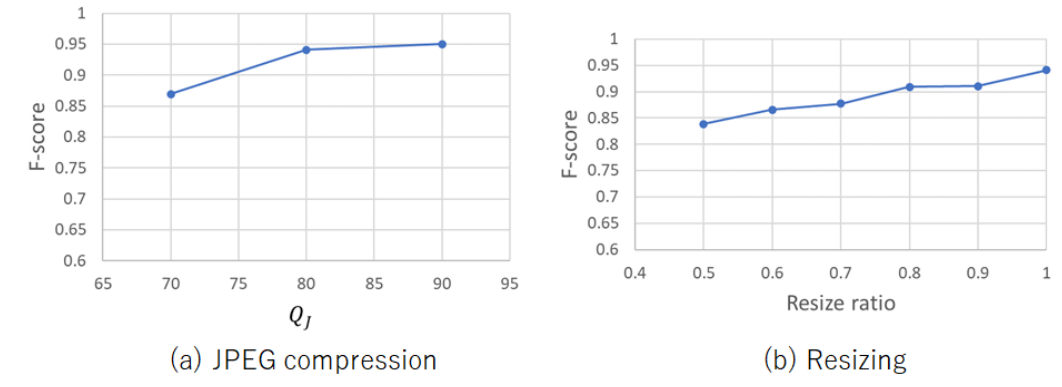
Figure 6. Robustness against compression and resizing (Image Manipulation Dataset). ( a ) JPEG compression; ( b ) Resizing.